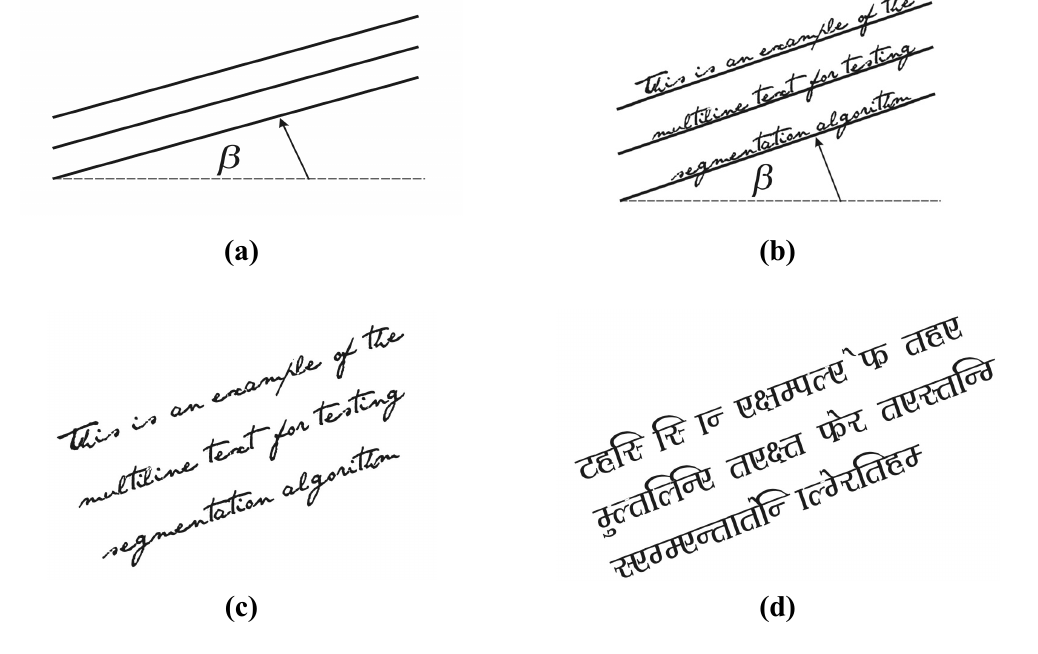
Figure 2. Multi-line straight text: (a) Reference line definition. (b) Text over reference line. (c) English text. (d) Bengali